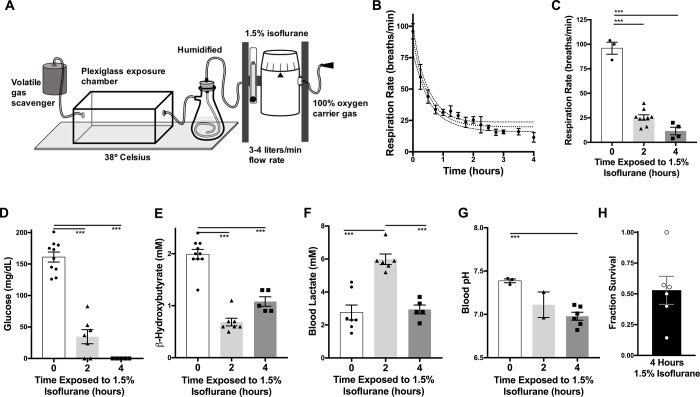
Physiological impact of prolonged anesthesia in P7 neonatal mice.(A) Experimental anesthesia setup. P7 neonatal mice were exposed to 1.5% isoflurane in 100% oxygen humidified air in a Plexiglass chamber, with gasses and chamber maintained at 38° C. (B) Respiratory rate in P7 mice as a function of time exposed to 1.5% isoflurane. Error bars depict standard error of the mean (SEM), dotted center lines depict non-linear best fit curve, dashed outer lines depict 95% confidence intervals (see Methods). n = 16 and 3 for 1.5% isoflurane and 1% isoflurane, respectively. (C) Comparison of respiratory rates in unexposed mice and mice anesthetized with 1.5% isoflurane for 2 or 4 hours ANOVA p-value<0.0001; ****p<0.0001 post-hoc pairwise t-test. n = 13, 7, and 5 for 0, 2, and 4 hours of exposure, respectively. (D) P7 mouse blood glucose concentration at baseline and at 2 or 4 hours of anesthesia with 1.5% isoflurane ANOVA p-value<0.0001; ****p<0.0001 post-hoc pairwise t-test. n = 13, 7, and 5 for 0, 2, and 4 hours, respectively. (E) P7 mouse blood ß-hydroxybutyrate concentration at baseline and at 2 or 4 hours of anesthesia with 1.5% isoflurane. ANOVA p-value<0.0001; ****p<0.0001 post-hoc pairwise t-test. n = 10, 7, and 5 for 0, 2, and 4 hours of exposure, respectively. (F) P7 mouse lactate concentration at baseline and at 2 or 4 hours of anesthesia with 1.5% isoflurane. ANOVA p-value = 0.0007; ***p = 0.0002, ****p<0.0001 post-hoc pairwise t-test. n = 7, 6, and 5 for 0, 2, and 4 hours of exposure, respectively. (G) P7 mouse blood pH at baseline and at 2 or 4 hours of anesthesia with 1.5% isoflurane. ANOVA p-value = 0.0007; *** = p<0.0005 post-hoc pairwise t-test. n = 3, 2, and 6 for 0, 2, and 4 hours of exposure, respectively. (C-G) Each data-point represents an individual animal. Error bars depict SEM. (H) Fraction of P7 mice surviving recovery period following exposure to 1.5% isoflurane for 4 hours. Data-points represent individual litters exposed for 4 hours, error bars represent SEM. Data represents a total of 6 litters (individual data-points) containing 4, 9, 3, 7, 7, and 5 pups, respectively. Total n = 35. *p = 0.0057 by one-sample t-test compared to a hypothetical value of zero.